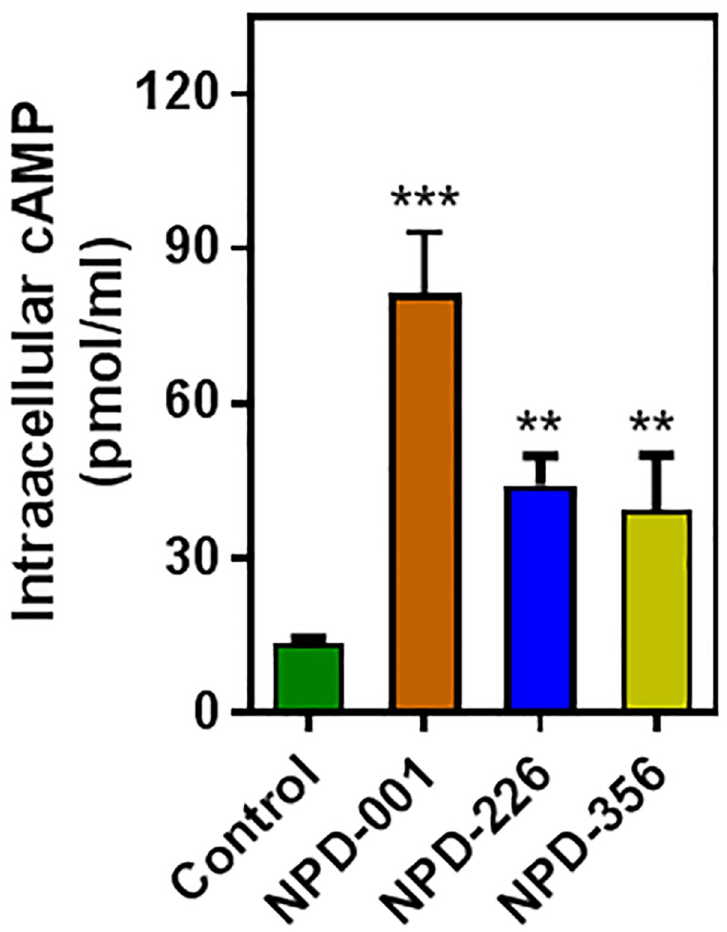
Fig 6. Analysis of intracellular cAMP after incubation of T . brucei bloodstream forms expressing SmPDE4A (TbrPDEB1 -/- , TbrPDEB2 -/- ) for 2 h with or without PDE inhibitor (each at a concentration of 2 × their EC 50 value). Each bar represents the average of three independent experiments (each analysed in duplicate) and SEM. Statistical significance was determined relative to the untreated control cells using Student’s unpaired t-test; � , P < 0.05; �� , P < 0.01; ��� , P <